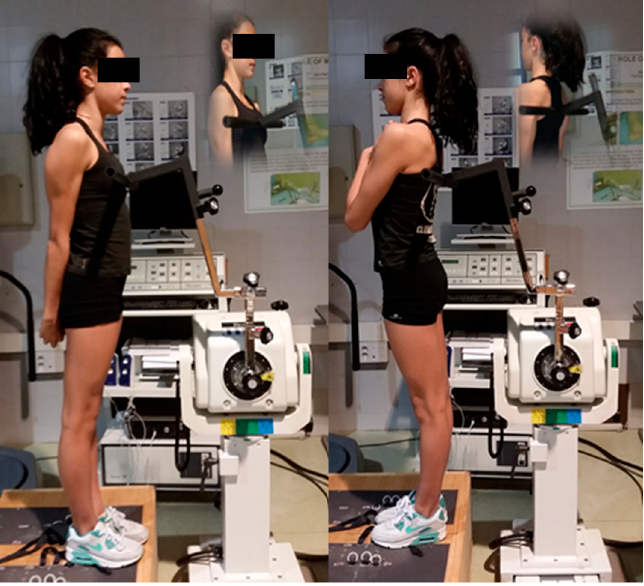
Figure 1. Core muscular training exercise. Figure 1. Isometric strength